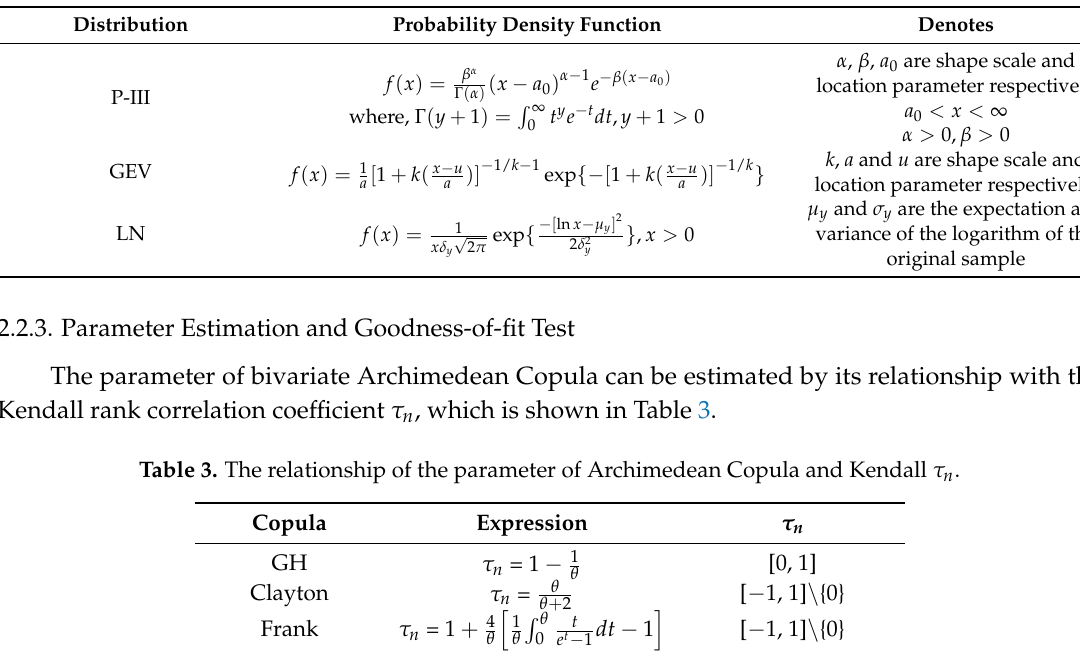
Table 2. Probability density distribution of marginal distribution.